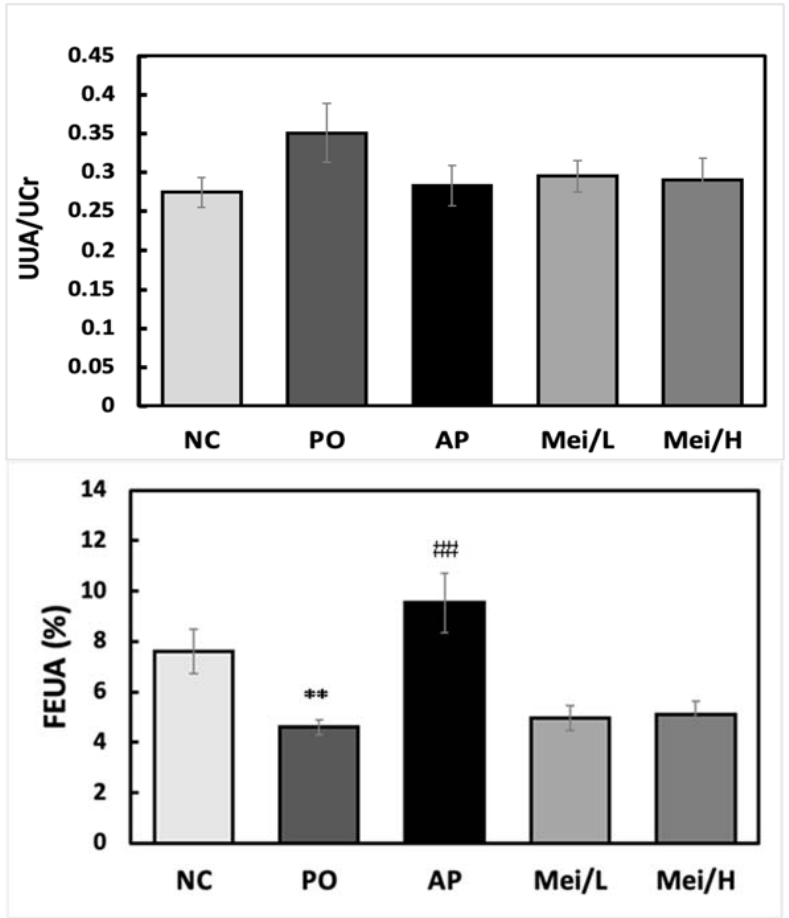
Figure 6. Effects of mei extract on urine uric acid to creatinine ratio (UUA/UCr) and fractional excretion of uric acid (FEUA) of potassium oxonate (PO)-induced hyperuricemic rats. NC designates the normal control group, and AP represents treatment with allopurinol. Mei/L and Mei/H represents treatment with low and high dosage of mei extract, respectively. Data are presented as mean ± SEM ( n = 5–6). ** p < 0.01 compared with the NC group and ## p < 0.01 compared with PO group.